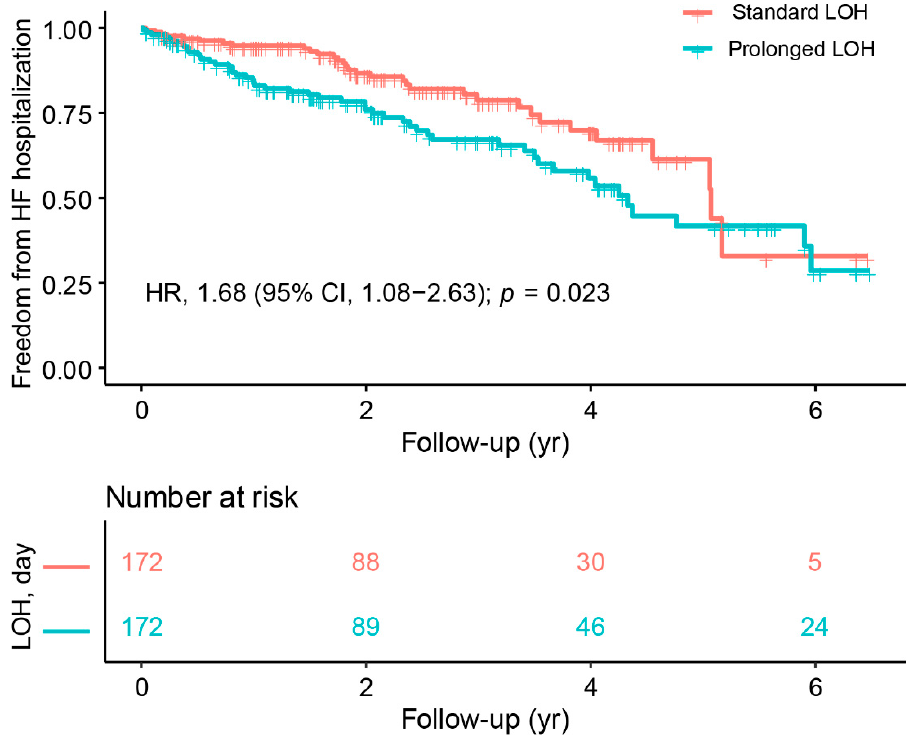
Figure 5. Kaplan–Meier survival curves of freedom from HF hospitalization.